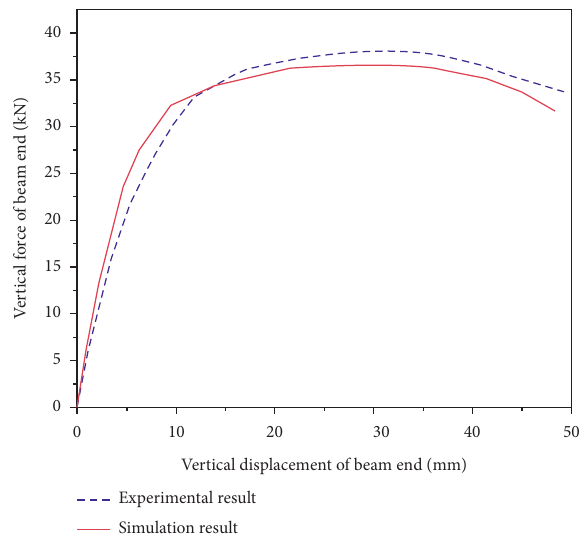
Figure 10: The skeleton curve of prefabricated reinforced concrete beam-column joints with grouted sleeves by finite element